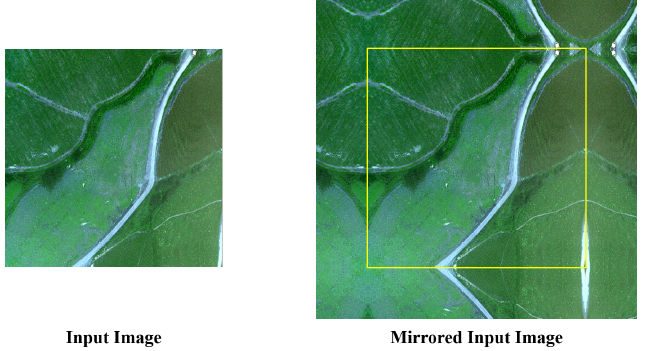
Figure 4. Mirroring extrapolation strategy to improve prediction result about border regions of an input image.